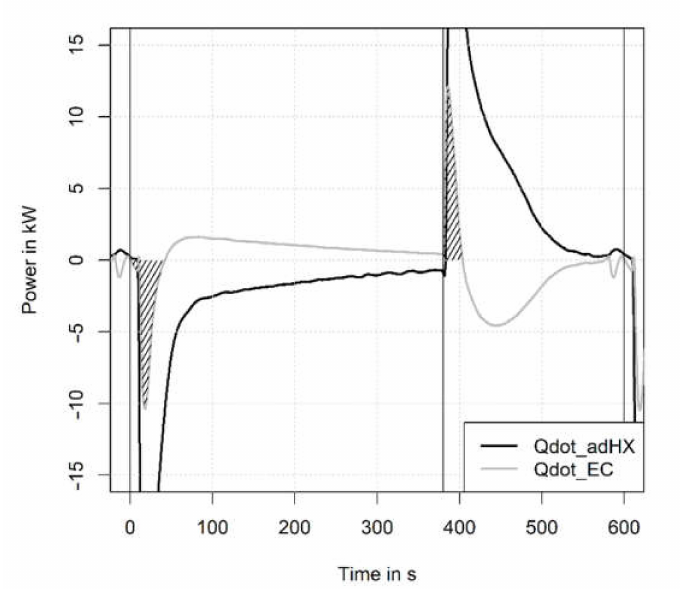
Figure 8. Calculated power of adsorption heat exchanger and evaporator-condenser over a complete cycle. Temperature boundary conditions are 10/35/95 ◦ C, 400 s adsorption, 200 s desorption half cycle time, volume flow rate is kept constant at 10 l/min for each heat exchanger throughout the whole measurement. The two shaded areas under the power curve of the EC during the switching phase indicate the cooling down and the heating up of the evaporator-condenser. The error bars are below the thickness of the plotted